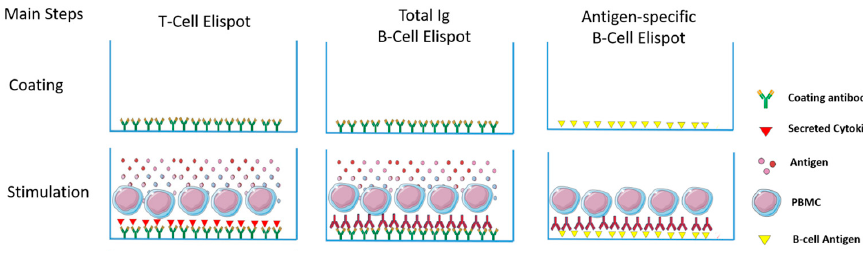
Figure 2. Schematic representation of the main steps on different Elispot categories used in the Tropical diseases field. Briefly, in the T-cell Elispot, a specific antibody is captured for the chosen Interleukin and is coated onto a PVDF plate and incubated, generally, overnight. After the blocking step, cells are added along with an appropriate stimulant (peptide antigen/positive control/polyclonal